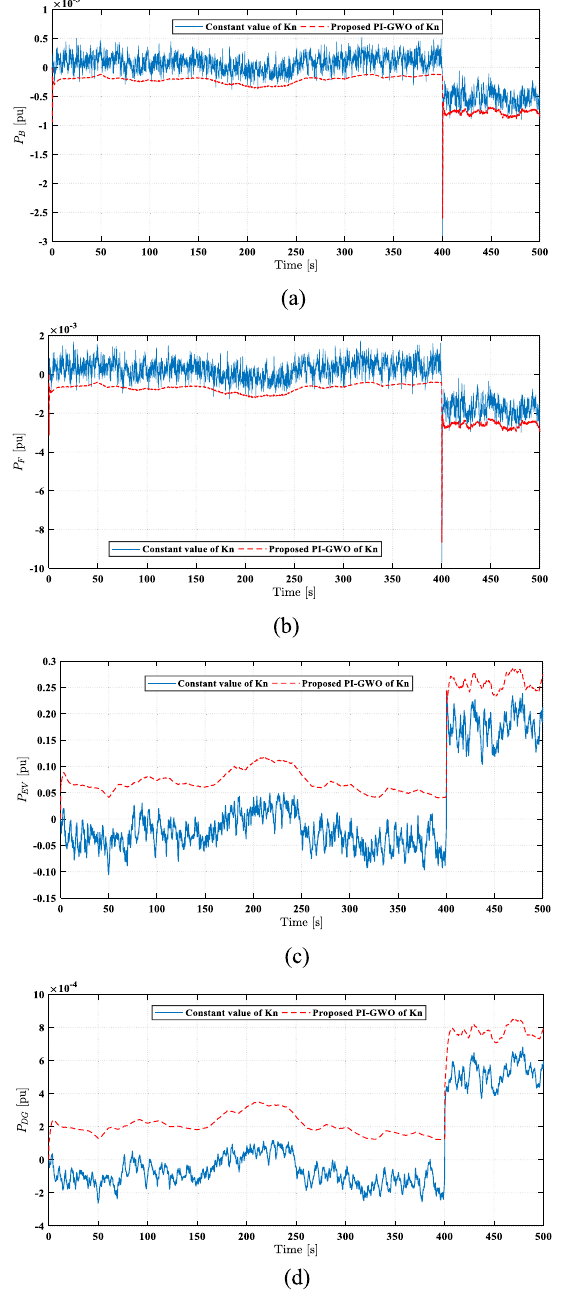
Fig. 9 The performance of HGS sources for Case 1: a battery power, b flywheel power, c EV power, and d DG